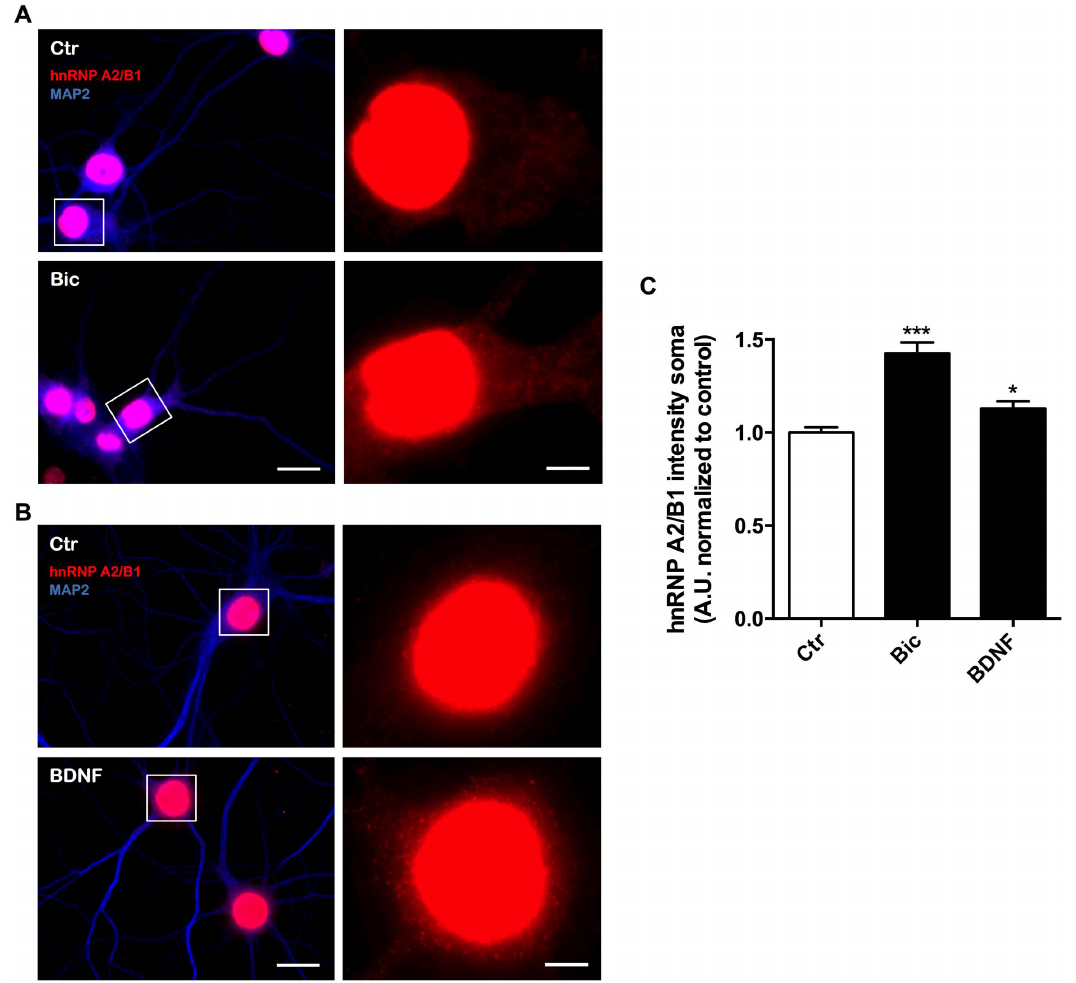
Figure 2. Synaptic activity and the neurotrophin BDNF increase the abundance of hnRNP A2/B1 protein in the soma of hippocampal neurons, outside the nucleus. (A) Cultured hippocampal neurons were stimulated or not with bicuculline (50 m M), 4-AP (2.5 mM) and glycine (10 m M) for 30 min and then the cells immunostained for MAP2 (blue), hnRNP A2/B1 (red). Scale bar=20 m m and 4 m m for low and high magnification images, respectively. (B) Cultured hippocampal neurons were stimulated or not with BDNF (100 m g/ml), for 30 min and then the cells immunostained for MAP2 (blue), hnRNP A2/B1 (red). Scale bar=20 m m and 4 m m for low and high magnification images, respectively (C) The intensity of hnRNP A2/B1 protein in the cell body was analysed in similar regions of interest within the soma, away from the nucleus, using ImageJ software. Results are normalized to control and are averaged of 4–7 different experiments performed in independent preparations. The following number of cells was used in the analysis of the somatic-localized hnRNP A2/B1 Ctr (n=71 cells), Bic (n=40 cells), BDNF (n=61 cells). Error bars,